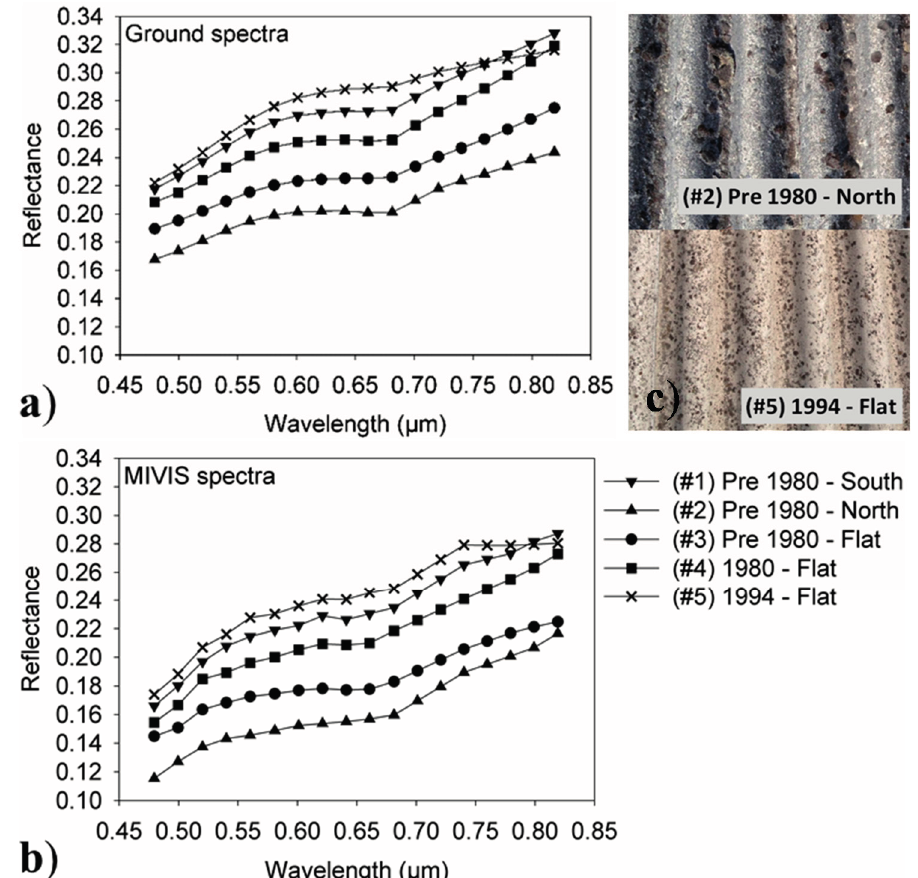
Figure 2. ( a ) Spectral signatures acquired on the roofs with the field spectroradiometer and resampled on the MIVIS sensor bands; ( b ) spectral signatures extracted from the MIVIS images on the same targets. Visible and near infrared wavelength range (0.48–0.82 µm) is shown; ( c ) Pictures taken on roofs laid in 1980 and in 1994, showing different levels of vegetation colonization and